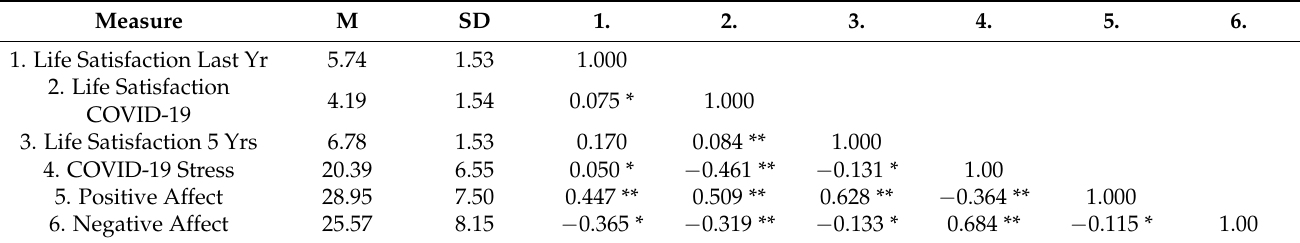
Table 2. Descriptive statistics: means and